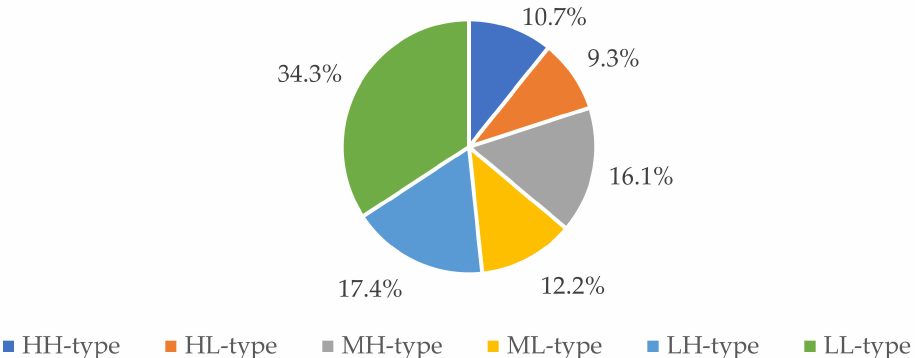
Figure 5. Ratios for the different household types in the study area.